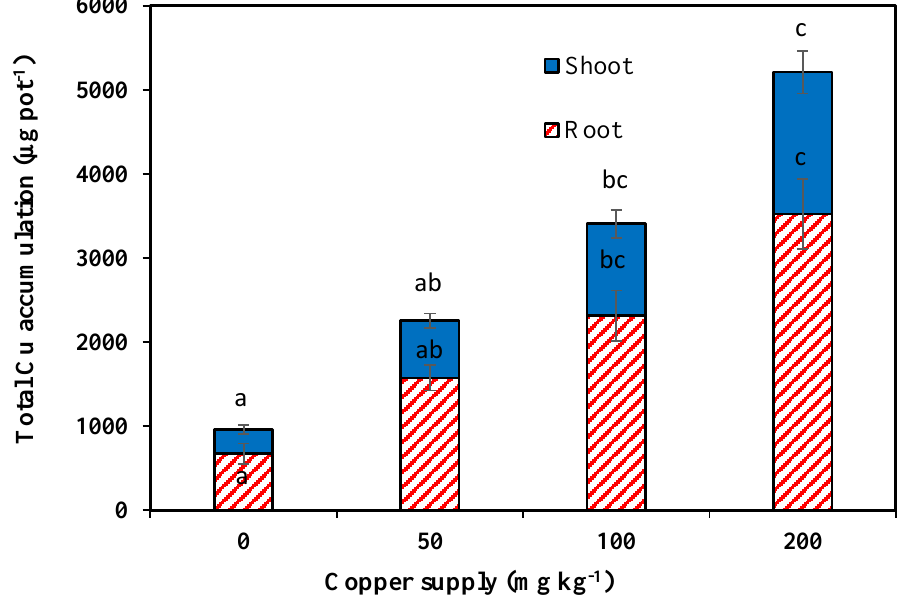
Figure 5. Copper accumulation capacity in Zea mays grown in contaminated soil with soil with 0, 50, 100 and 200 mg kg − 1 copper. Mean values that do not share a letter are significantly different at p = 0.05 (mean ± S.E.; n = 3).